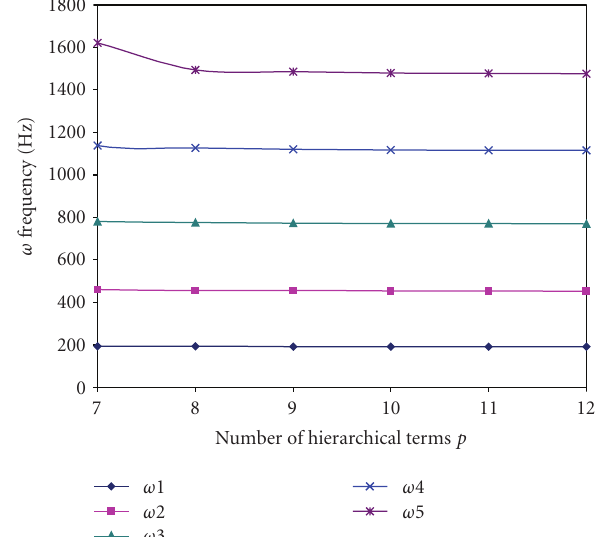
Figure 8: Convergence of the frequency ω for the 5 bending modes of the clamped-clamped (C-C) shaft as a function of the number of hierarchical terms p